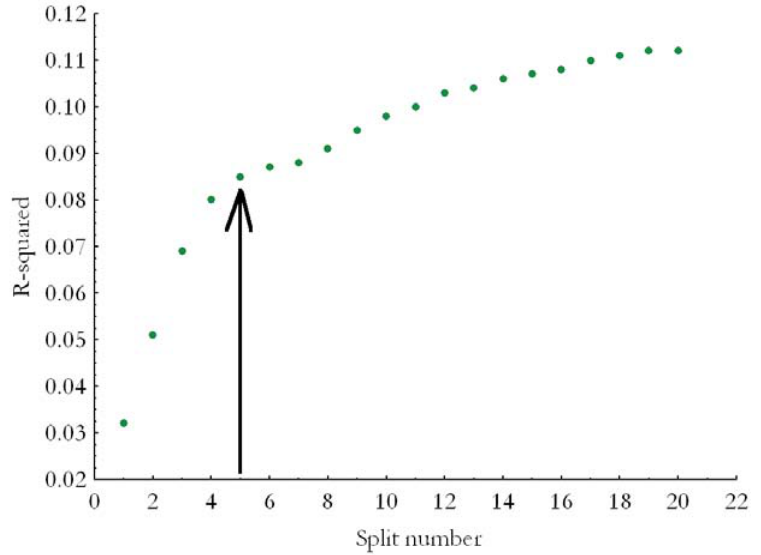
Figure 4. The variance explained (R 2 ) by the classification tree after each split in the data. The tree was pruned at the number of splits where the graphs abruptly level off, indicated by an arrow (here, split number